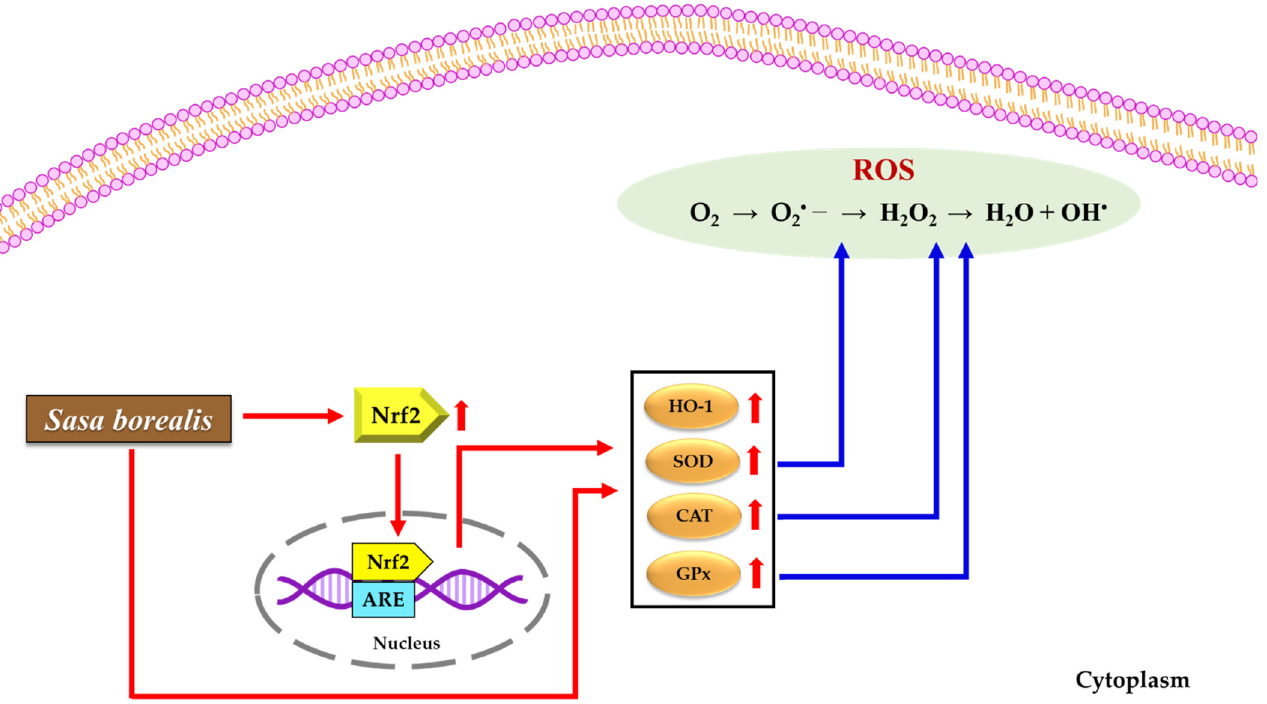
Figure 5. Probable mechanism of the neuroprotective effect of Sasa borealis on H 2 O 2 -treated PC12 cells. ARE, antioxidant response element; CAT, catalase; GPx, glutathione peroxidase; HO-1, hemeoxygenase-1; H 2 O 2 ; hydrogen peroxide; Nrf2, nuclear factor erythroid 2-related factor 2; ROS, reactive oxygen species; SOD, superoxide dismutase.